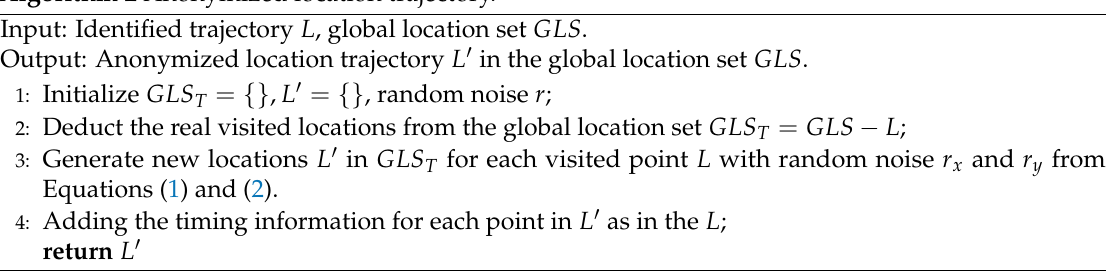
Algorithm 2 Anonymized location